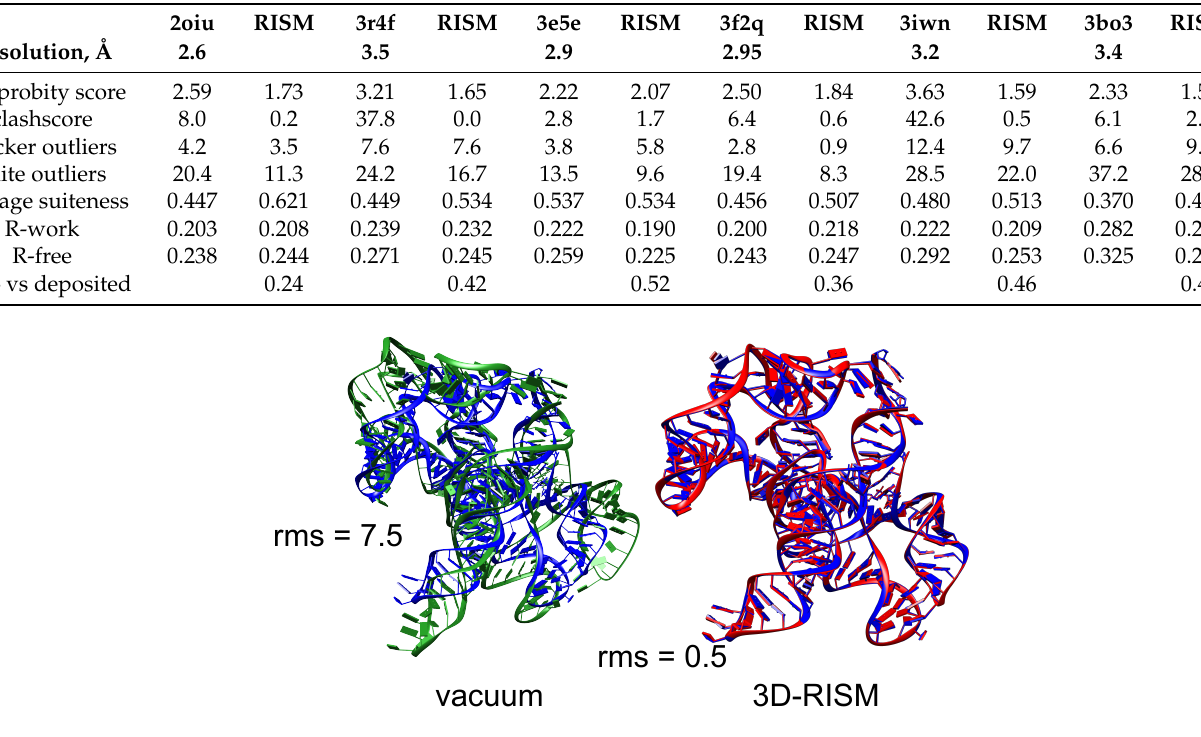
Figure 5. Blue: Experimental structure from X-ray crystallography (PDB ID 1y0q); red: Structure from a 3D-RISM crystal minimization; green: Structure from a crystal minimization with no solvent correction. RMS give the root-mean-square deviation (in Å) of all non-hydrogen atoms from the crystal